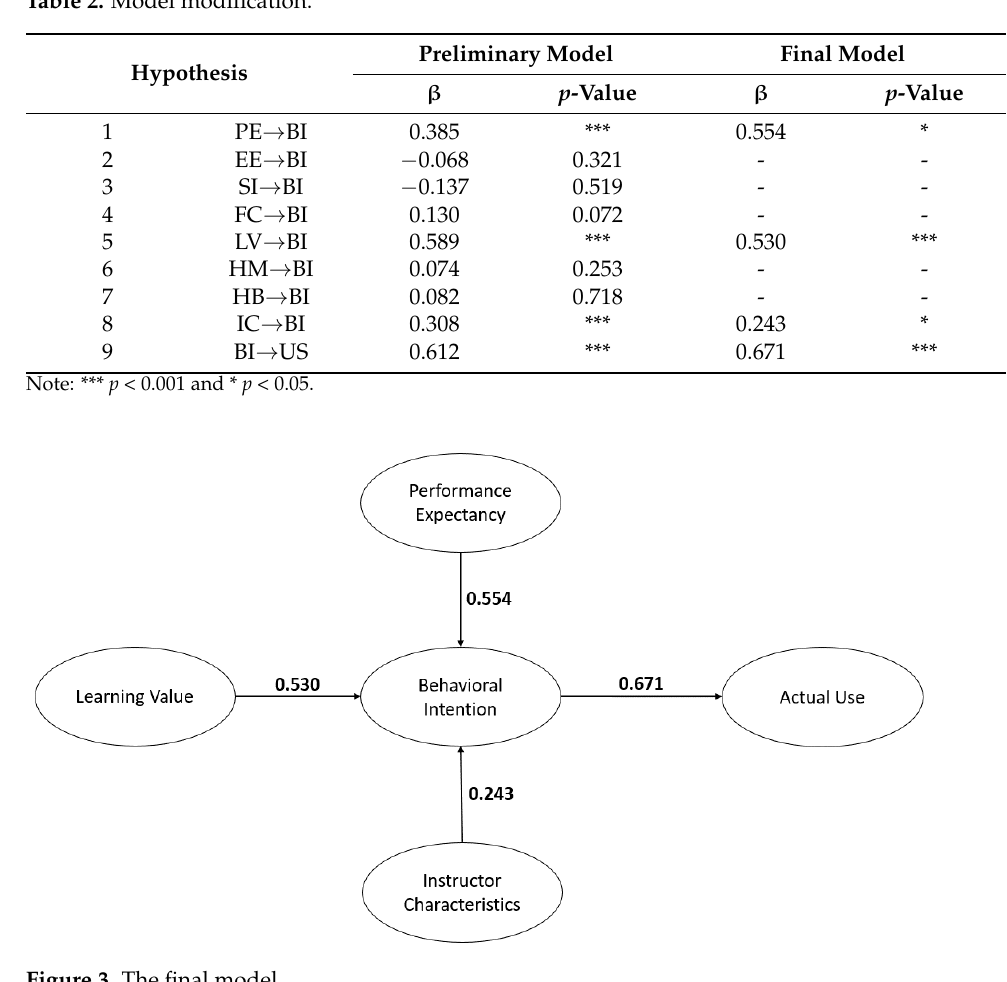
Figure 3. The final model.